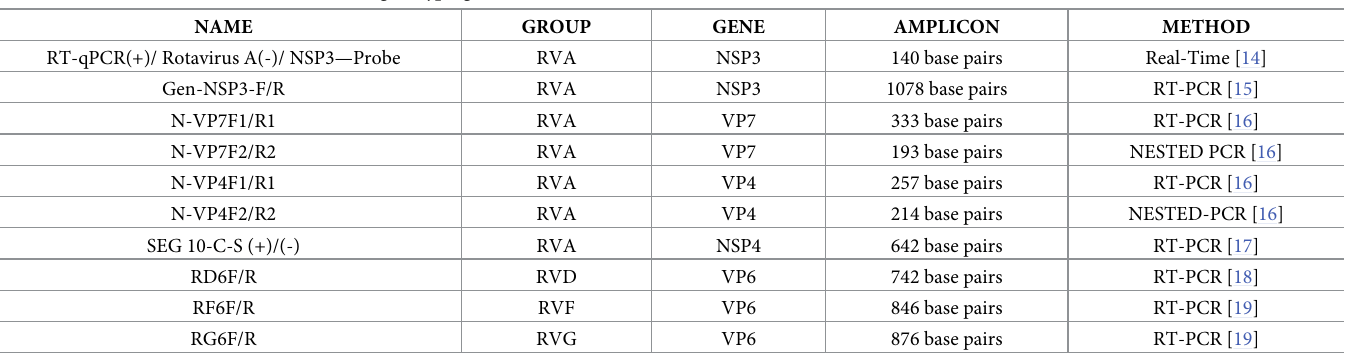
Table 1. Primer sets used to RV detection and genotyping.